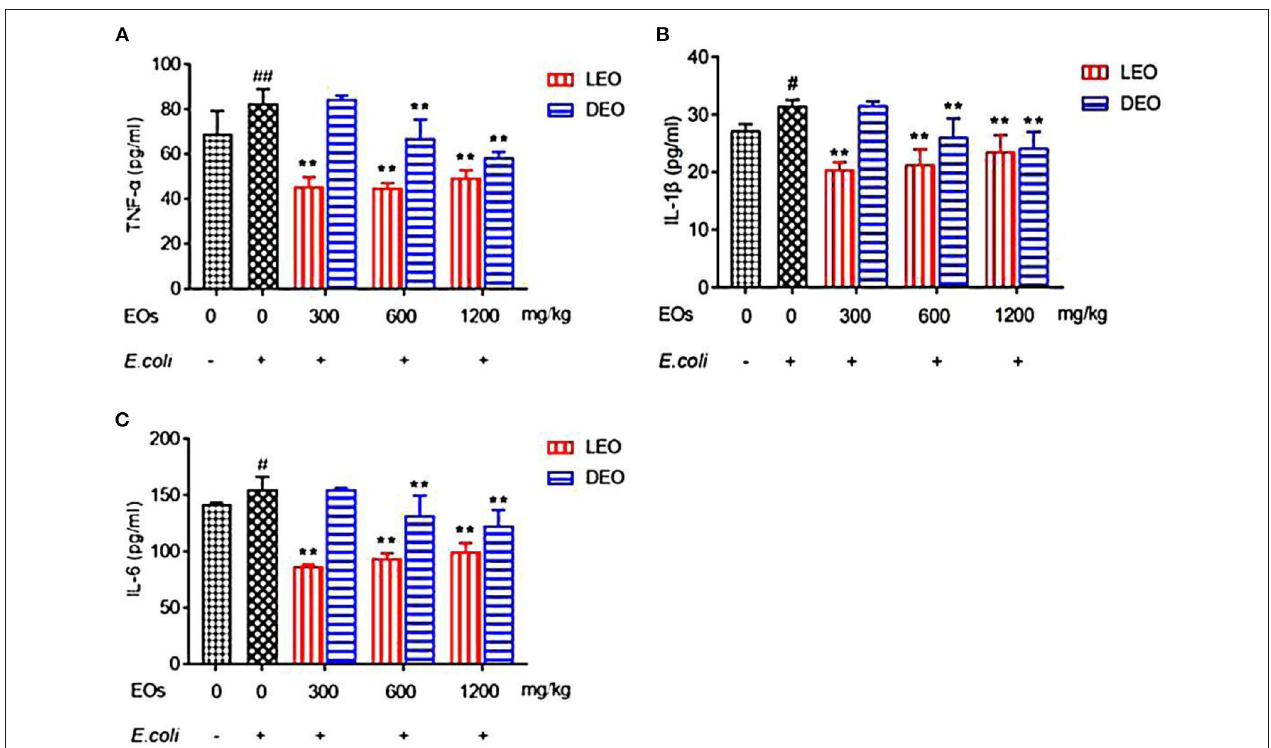
FIGURE 3 | Effects of LEO and DEO on plasma concentration of tumor necrosis factor α [TNF- α ; (A) ], interleukin-1 β [IL-1 β ; (B) ], and interleukin 6 [IL-6; (C) ] in E. coli injected mice. Data were presented as mean ± standard error of mean (mean ± SEM) ( n = 8). The 1st column was normal saline group (NS) with no E. coli and no EO. The 2nd column was the E. coli group with no EO. The 3rd − 8th column are the LEO and DEO groups with doses at 300, 600, and 1,200 mg/kg BW, respectively. # P < 0.05 and ## P < 0.01, E. coli group compared with NS group; Essential oil (E) and its different dose (D) had significant effects on plasma inflammatory factors ( P E < 0.01, P < 0.01), and their interaction (E × D) was significant ( P < 0.01). ** P < 0.01, EO groups compared with E. coli group. LEO, lemon essential oil; D E × P D DEO, d-limonene essential